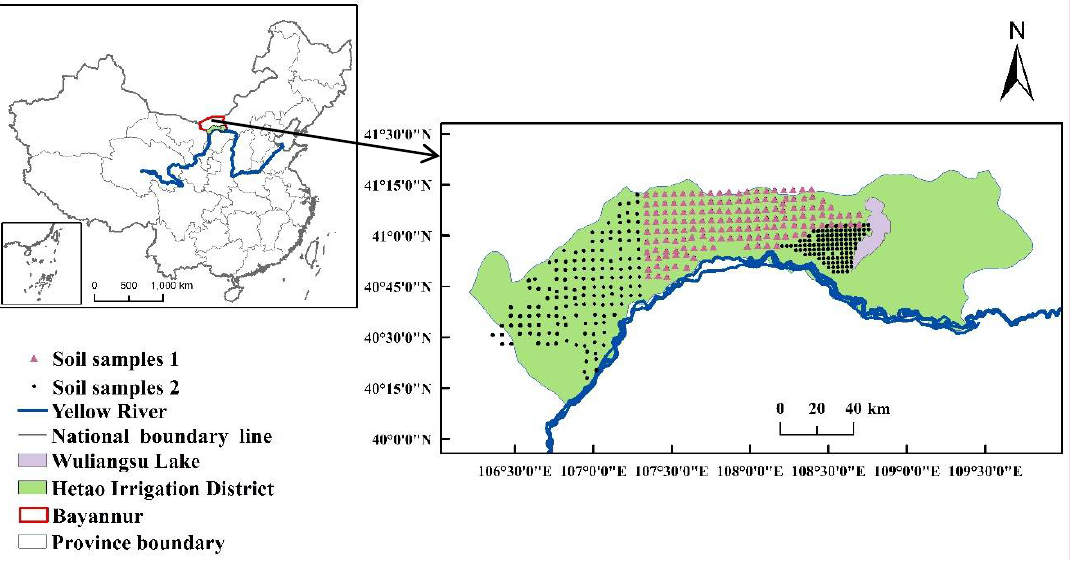
Figure 1. Study area in Hetao Irrigation District. Triangle denotes that 151 topsoil and the corresponding 151 subsoil samples were collected (soil samples 1), and circle denotes that 61 topsoil samples were collected (soil samples 2).